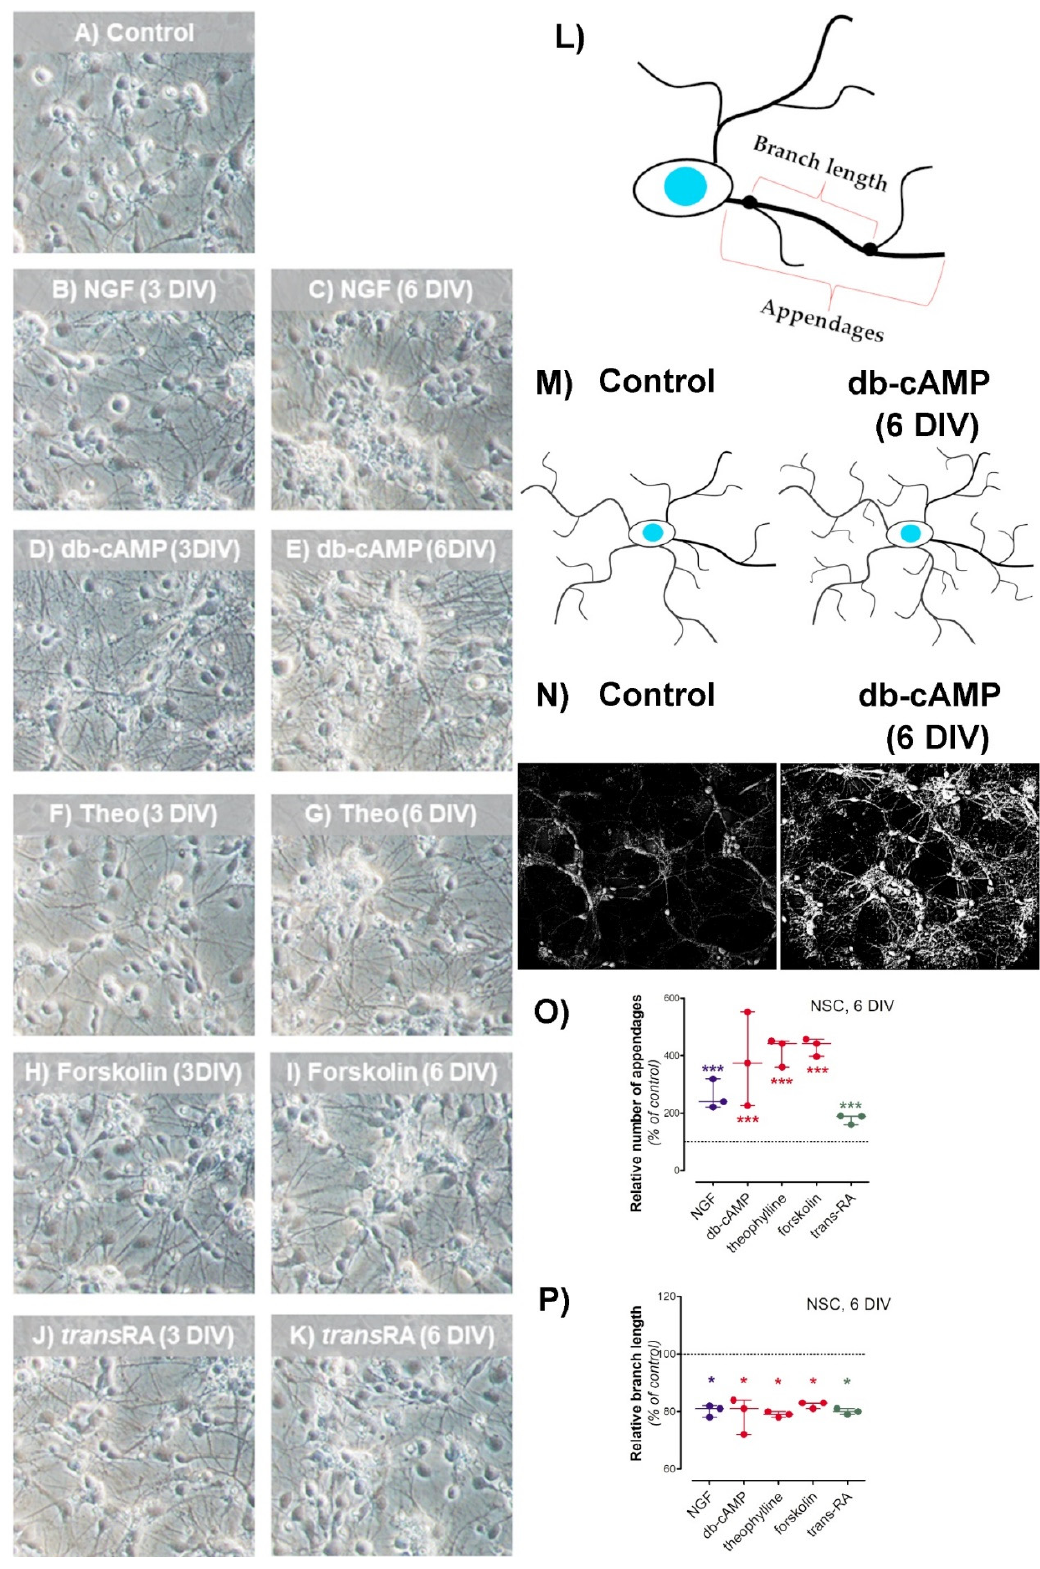
Figure 2. Impact of differentiation factors on neural stem cell (NSC) morphology was analyzed with the following factors: ( A ) Control; ( B , C ) nerve growth factor (NGF, 10 ng/mL); ( D , E ) dibutyryl-cyclic AMP (db-cAMP, 1 mM); ( F , G ) theophylline (Theo, 10 µM); ( H , I ) forskolin (20 µM); ( J , K ) trans- retinoic acid (transRA, 1 µM); Images are representative for 4 independent experiments. The cell morphology analysis was conducted after 6 DIV with Neuron J plugin (from ImageJ): ( L )—cartoon definition of cell appendages and branches; ( M )—cartoon visualization of cell morphology cultured without and with growth factors; ( N )—ImageJ processed images of NSC cultured without and with growth factors; ( O )—the number